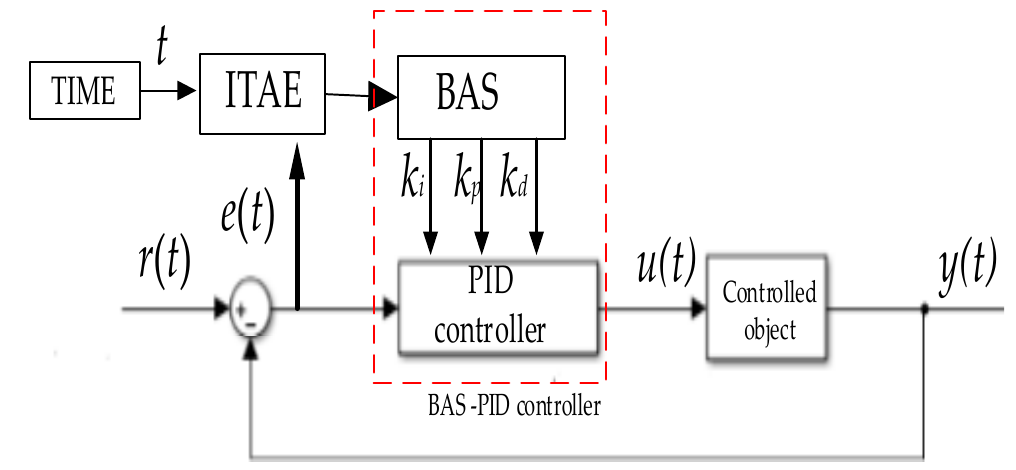
Figure 2. Block diagram of the BAS-PID controller.